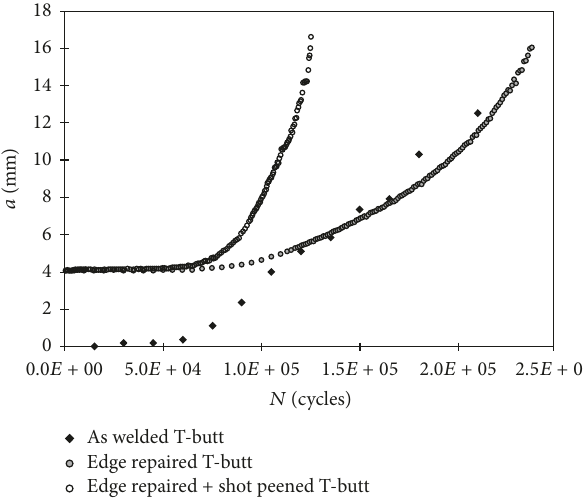
Figure 8: Fatigue crack growth versus number of load cycles for fatigue tested